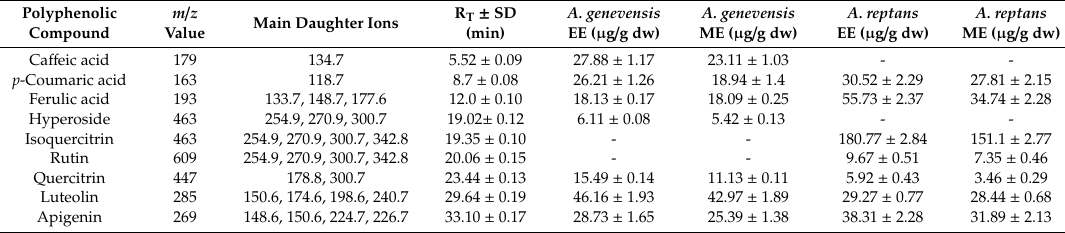
Table 2. The content in polyphenolic compounds from A. genevensis ( Ag1 ) and A. reptans ( Ar1 ) extracts by HPLC ( µ g / g